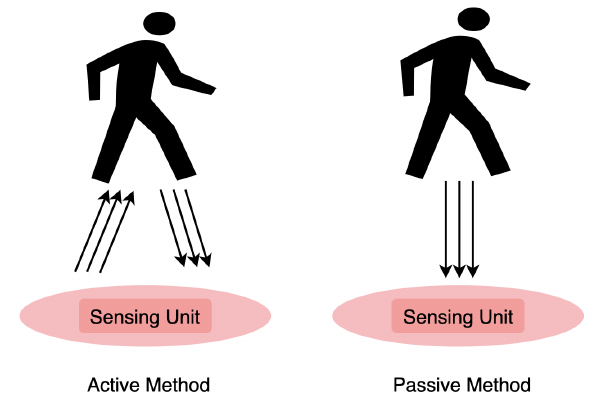
Figure 4. Wave-based human-centric sensing in two methods: active and